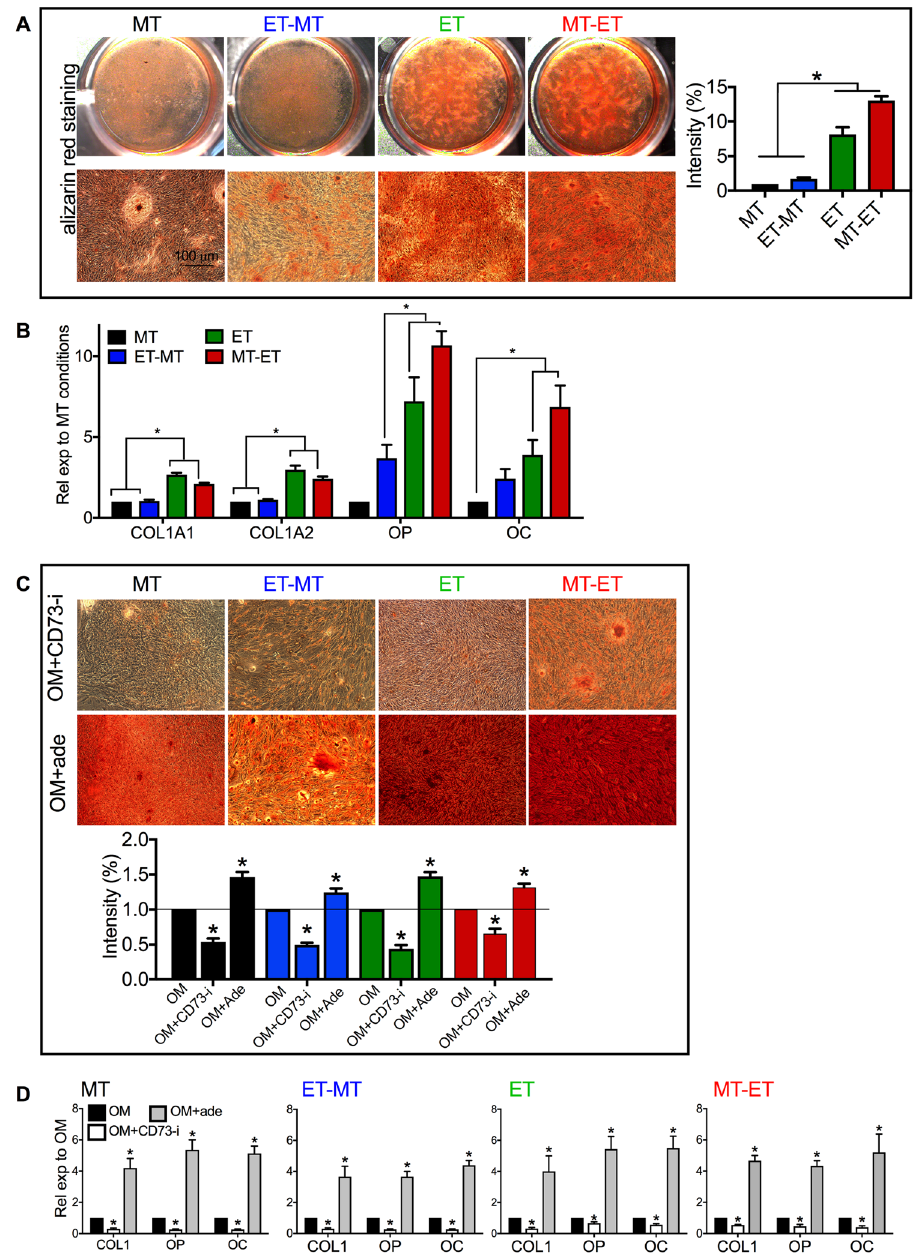
Figure 4. In vitro osteogenic differentiation of RS-hAFSCs. ( A ) The media of passage 10 RS-hAFSCs cultured in different conditions was replaced by osteogenic medium (OM) for 3 weeks. The cultures were subsequently stained with Alizarin red to visualize areas of calcium deposition. The graph on the right hand represents the staining intensity of alizarin red staining relative to MT condition. ( B ) qRT-PCR to show expression of the osteogenic genes COL1A1, COL1A2, OP and OC in the four groups. GAPDH was used as internal control. ( C ) Passage 10 cells were cultured in osteogenic media supplemented with either the CD73 inhibitor adenosine 5 ′ -( α , β -methylene) diphosphate (OM + CD73i) or with the CD73 downstream product adenosine (OM + ade) for 3 weeks and subsequently stained with Alizarin red. The bottom panel represents the staining intensity relative to all condition. ( D ) qRT-PCR for collagen type I ( COLI ), osteocalcin ( OC ) and osteopontin ( OP ), normalized by their expression in RS-hAFSCs cultured in MT conditions. GAPDH was used as internal control. Data represent mean ± SEM for 3 samples per group. SEM: standard error of the mean. * P < 0.001. (mean ±